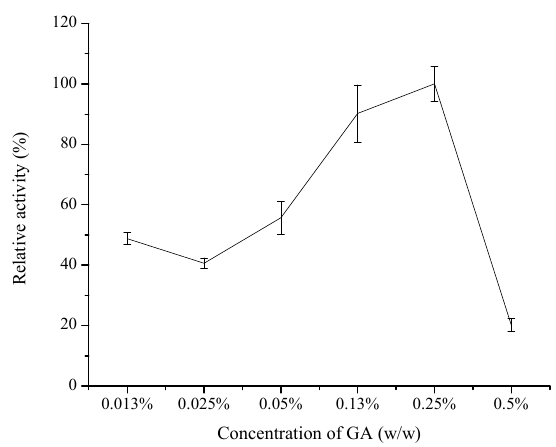
Figure 1. Effect of GA concentrations on the relative activity of the immobilized COX-2 ( n = 3).